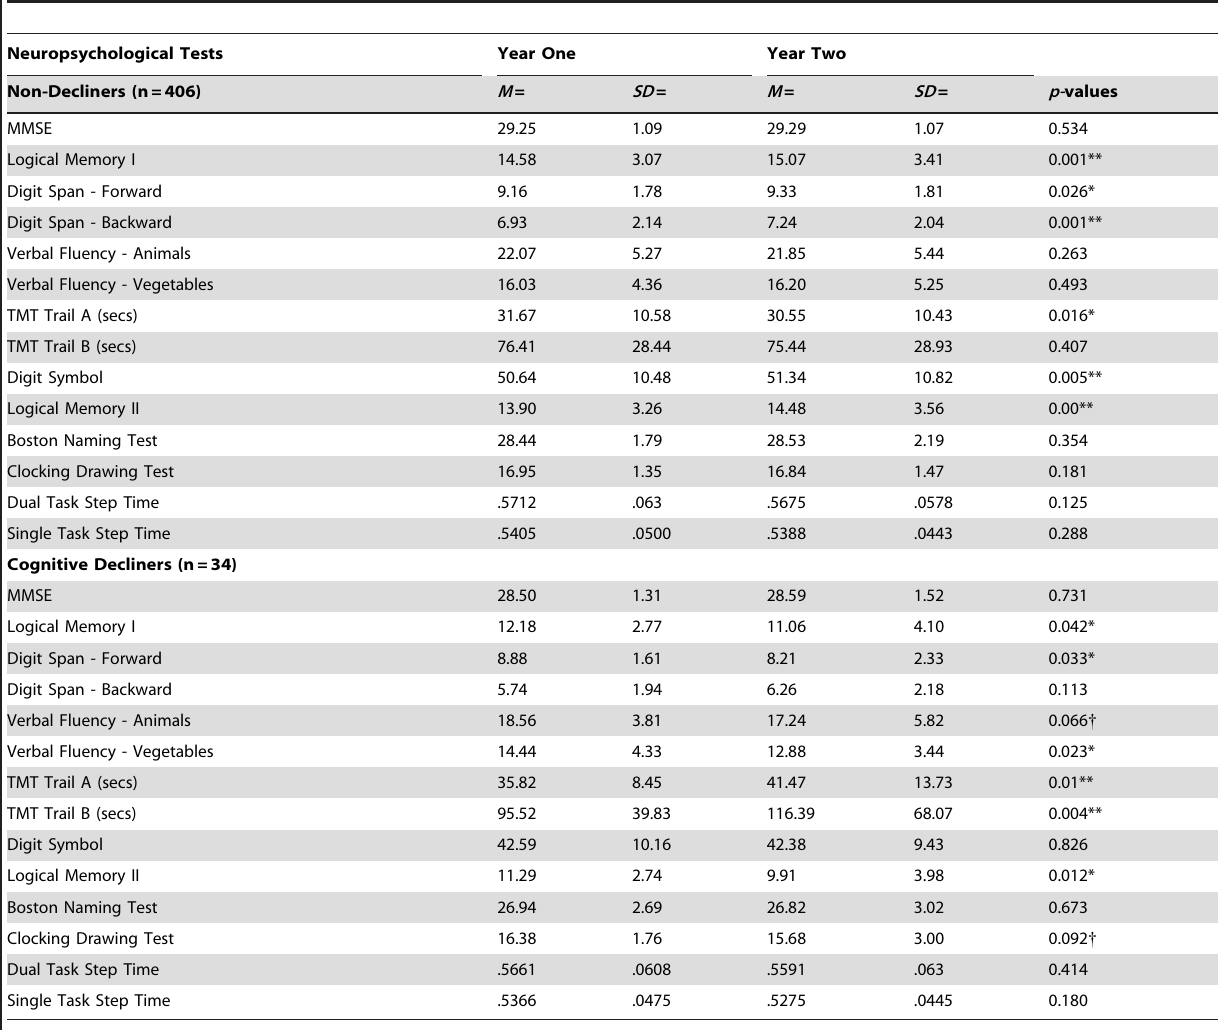
Table 4. Neuropsychological Characteristics at Year One and Two by UDS Groups.